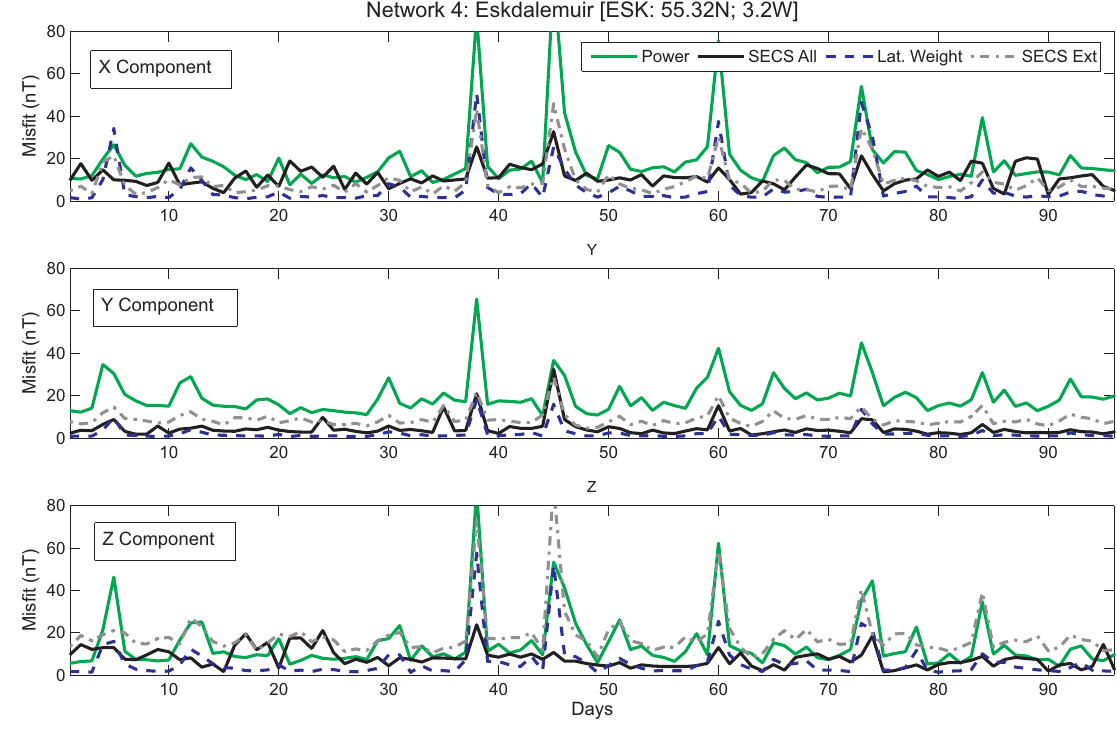
Fig. 5. Comparison of the daily power of measured external disturbances (green solid) with the misfit estimate from the SECS (black solid), Latitudinal Weighted (blue dashed) and SECS (External only) (grey dot-dash) method over a three-month period (April–June 2005) at magnetic observatory Eskdalemuir